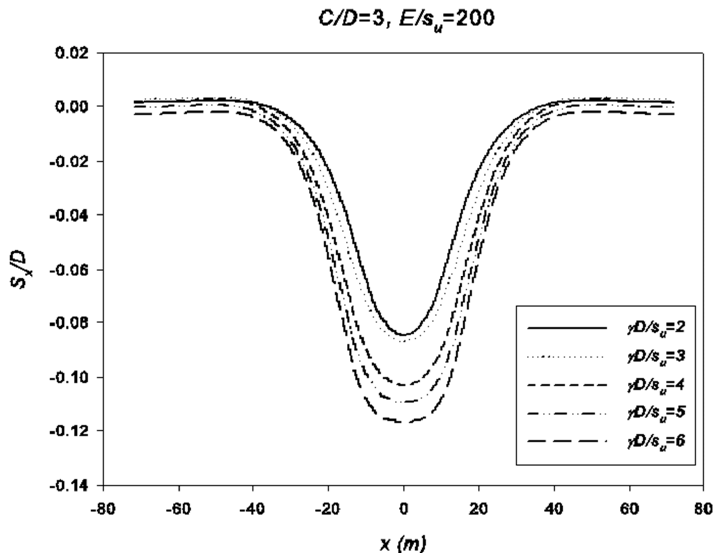
Figure 14. Typical settlement profiles with respect to C/D (depth ratio).